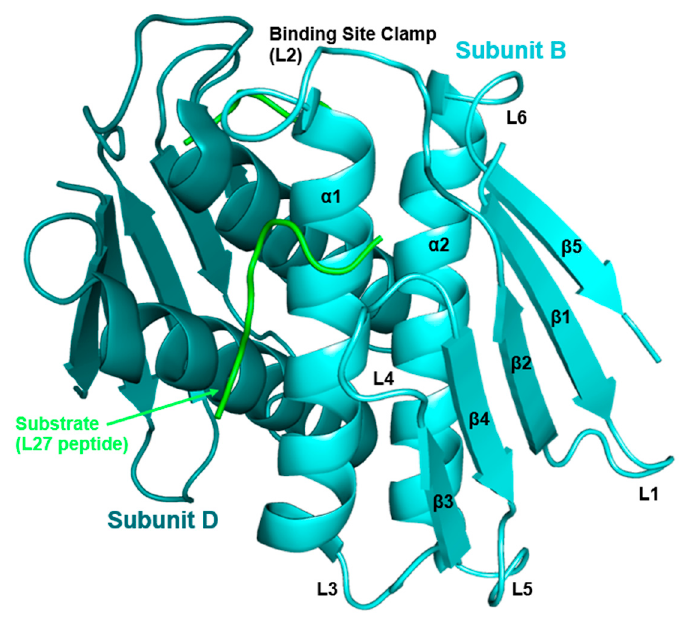
Figure 4. General structure of Prp.